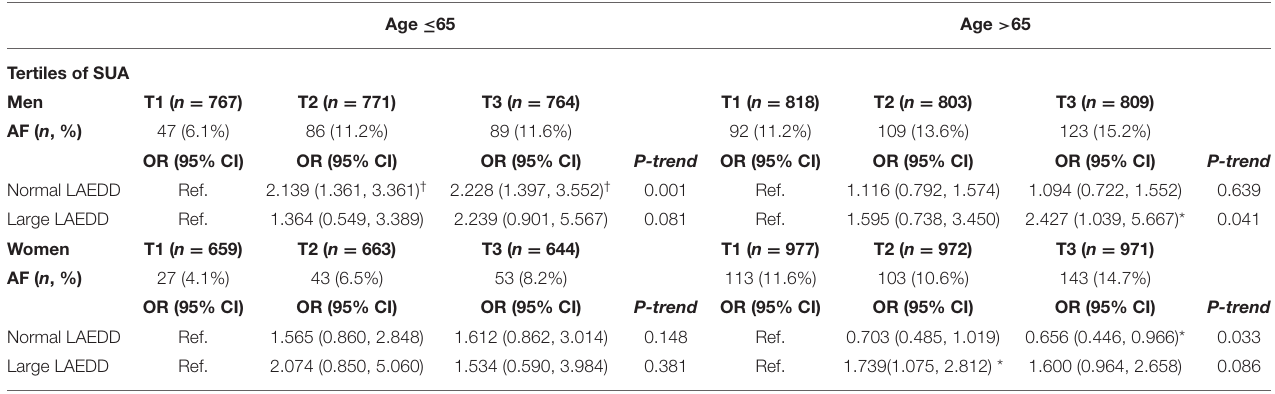
TABLE 6 | The impact of serum uric acid in atrial fibrillation patients with normal and wide left atrium diameter. Age ≤ 65 Age > 65 Tertiles of